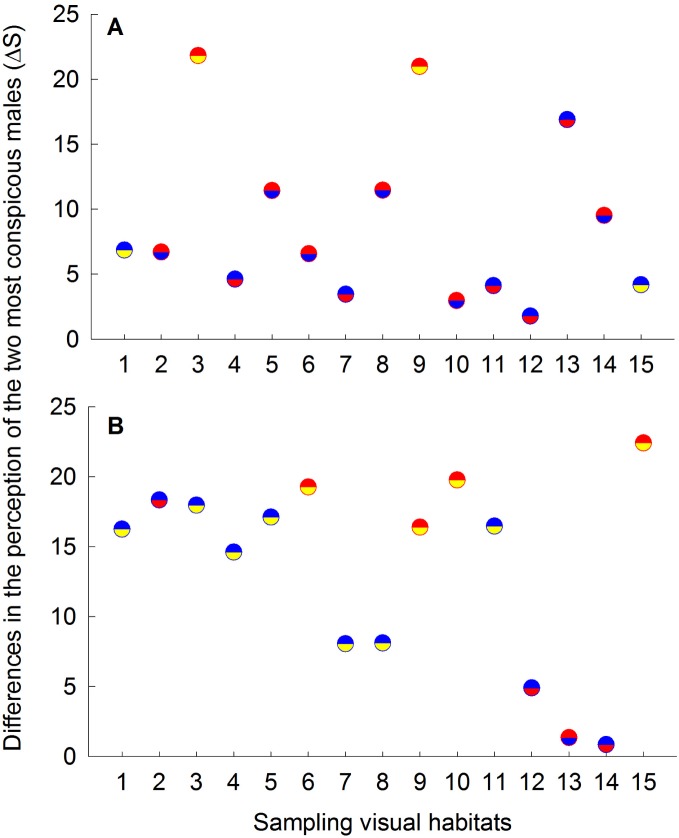
Differences in the perceived chromatic contrast between the two most conspicuous males as perceived by conspecifics across different sampling sites in the (A) east and (B) west populations.Differences were calculated by subtracting the ΔS values of the most conspicuous color morphs from the ΔS values of the second most conspicuous morph at each sampling site. Upper half of each circle represents the most conspicuous male color morph, while the lower half represents the second most conspicuous color morph at each site. Blue, red and yellow male color morphs are represented by blue, red and yellow colors, respectively.